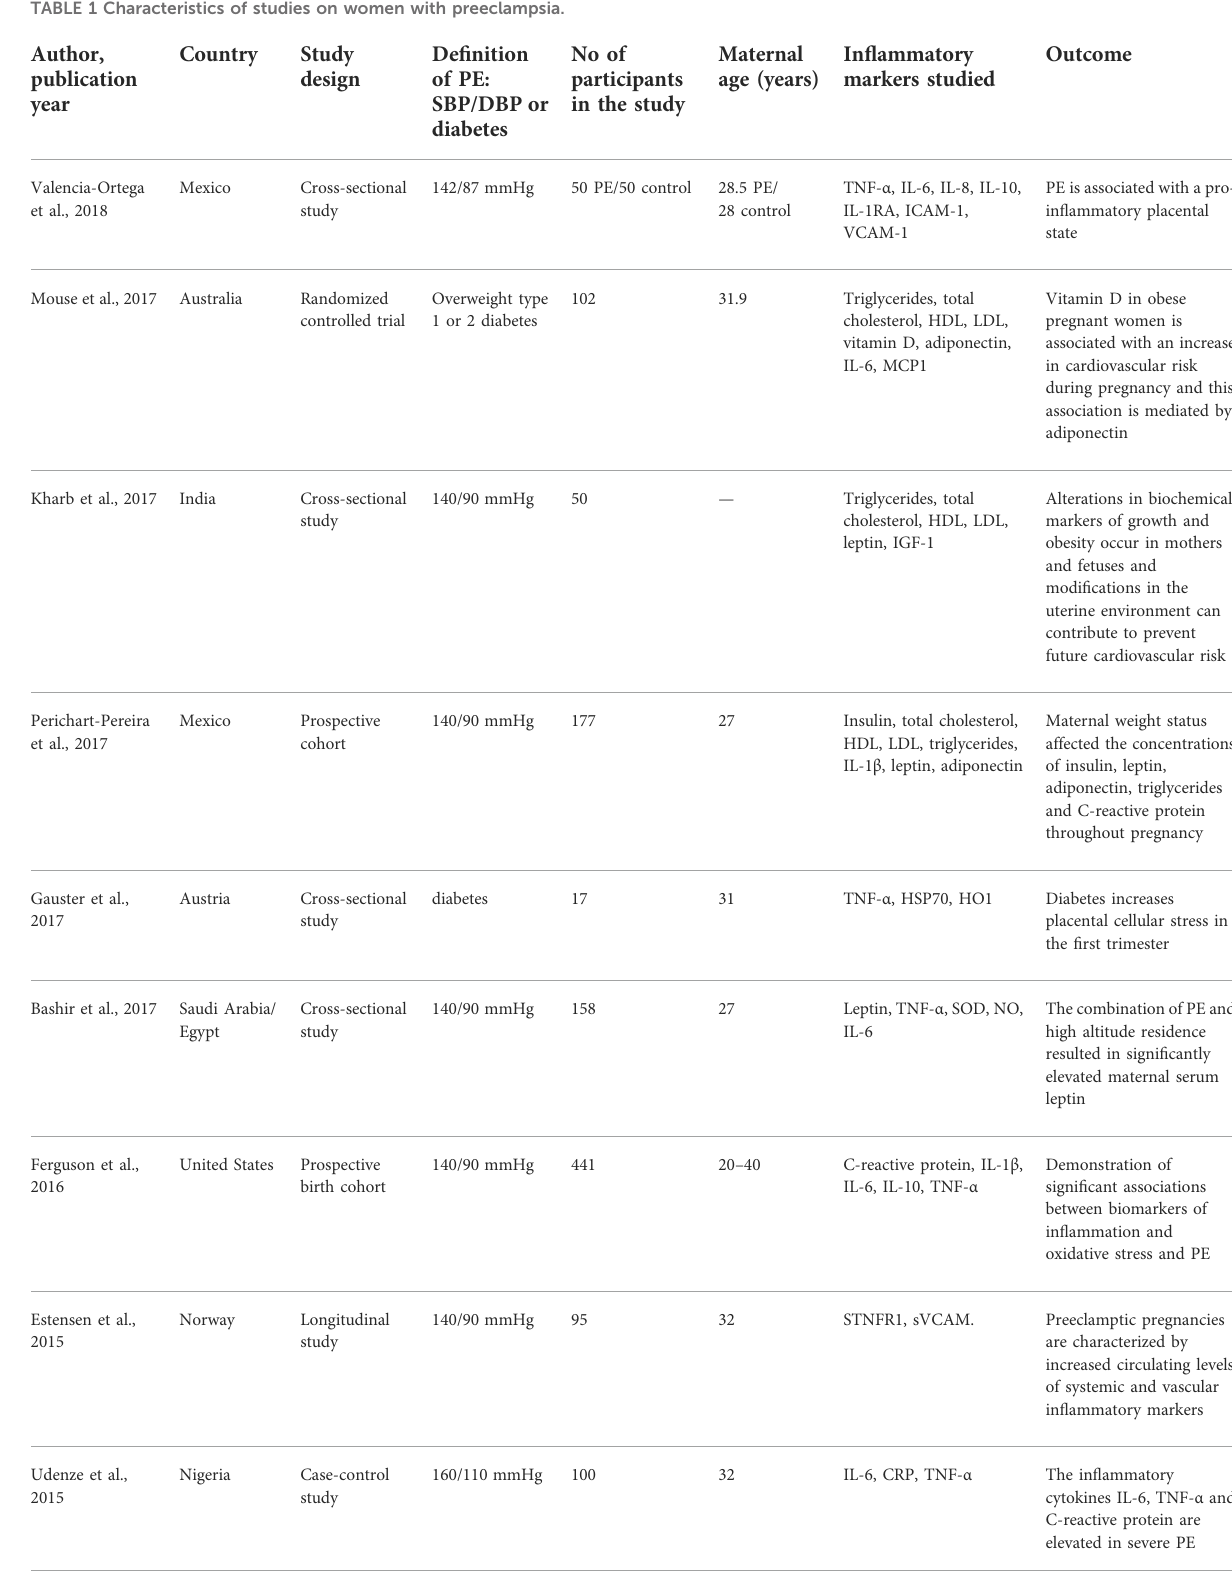
TABLE 1 Characteristics of studies on women with